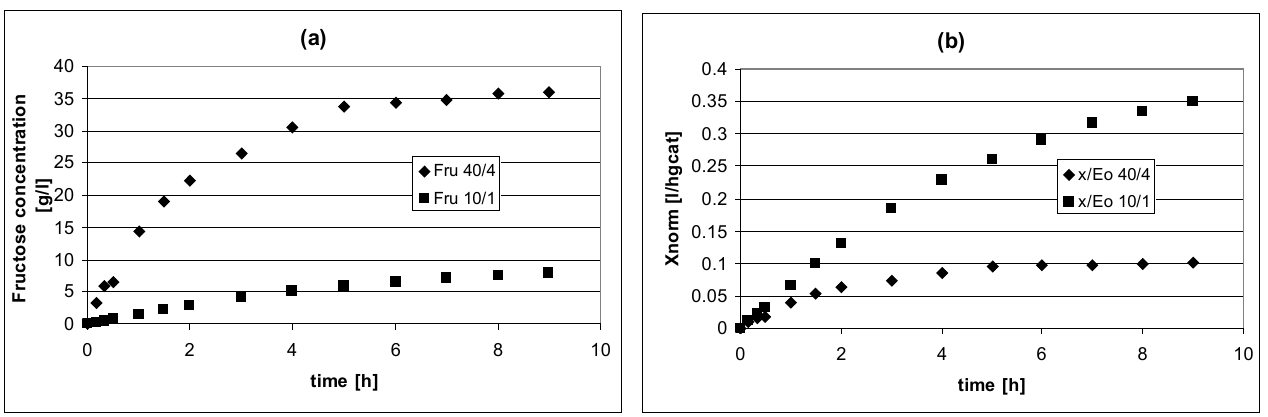
Figure 3. Performance comparison at S terms of fructose concentration (a) and normalized inulin conversions